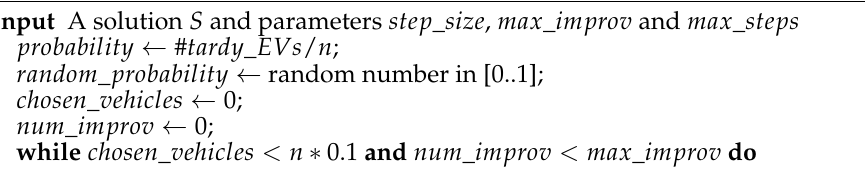
Algorithm 3 Second type improvement for the onlooker bee phase o _ meth